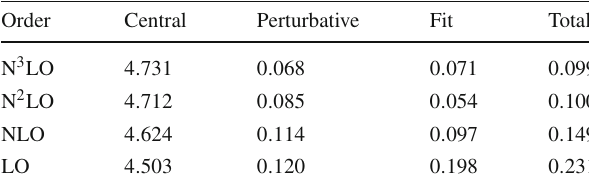
Table 3 Results of the calibration for m b = 4 . 2GeV using the world average value of α s . Rows second to fifth correspond to N 3 LO, N 2 LO, NLO and LO, respectively. The second and third column show the central value and uncertainty due to the theory scan, while in the fourth and fifth column the fit and total uncertainties are depicted Order